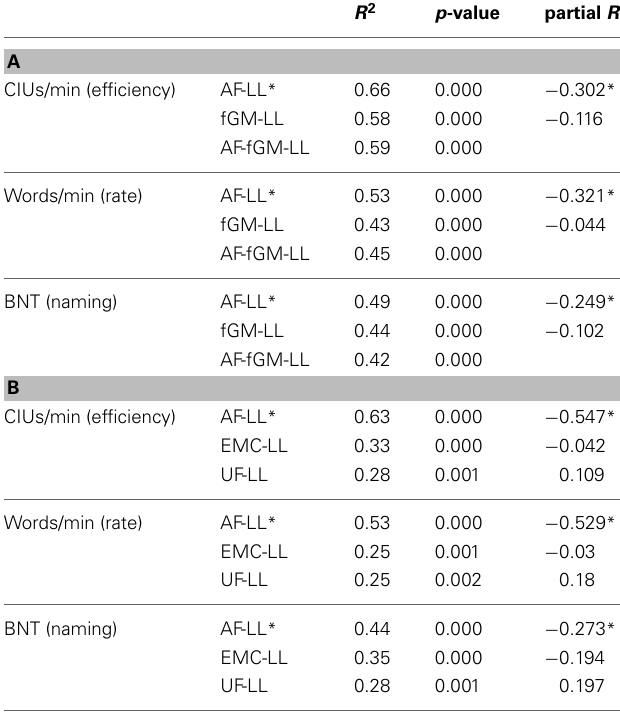
Table 2 | Linear regression coefficient values for AF, fGM, Combined AF-fGM, EMC, and UF lesion loads predicting CIUs/minute and BNT-Aphasia Short